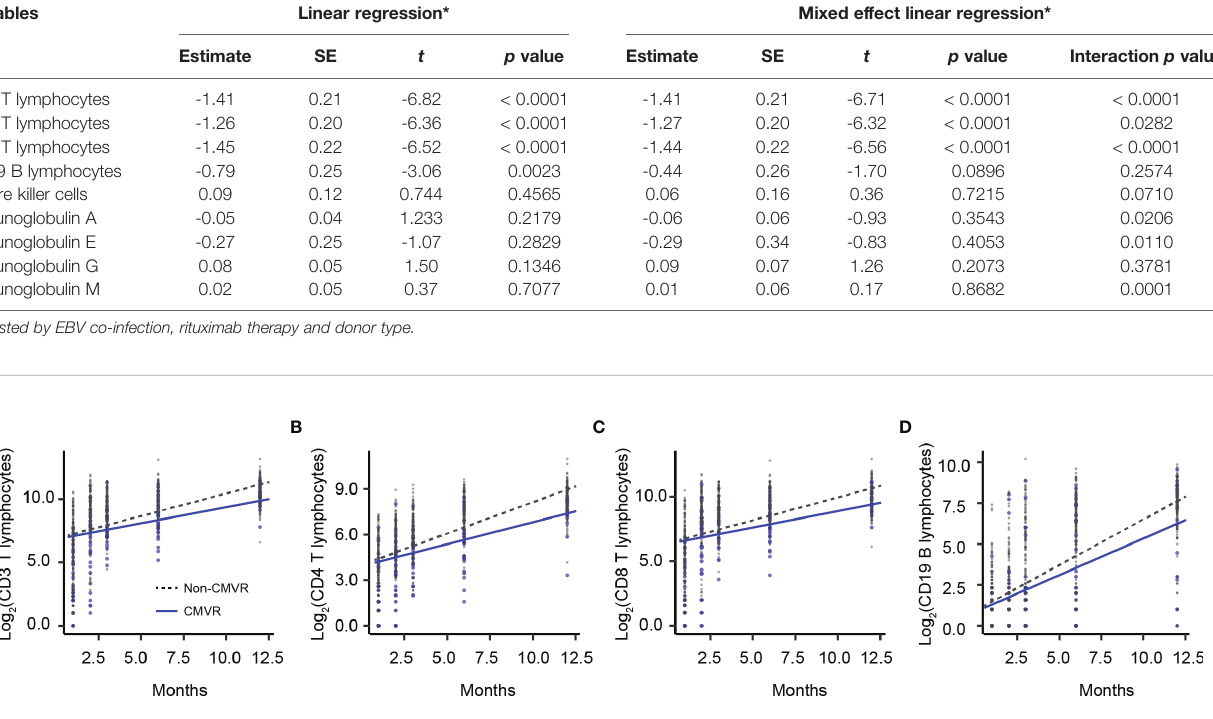
FIGURE 4 | The overall trend of immune recovery of four T lymphocytes within one year after hematopoietic stem cell transplantation. (A) CD3 T lymphocytes, (B) CD4 T lymphocytes, (C) CD8 T lymphocytes, and (D) CD19 B